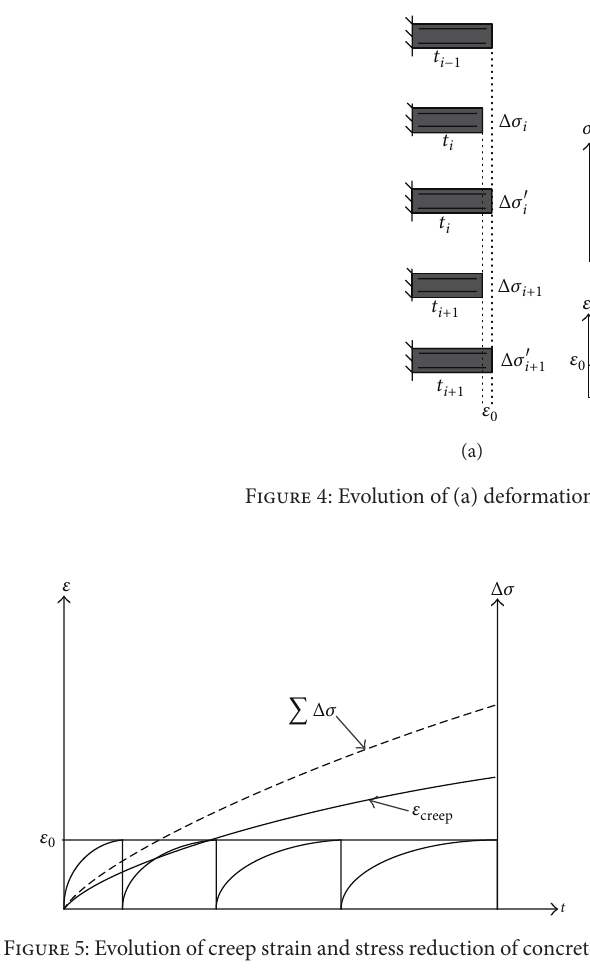
(Figure 6). Concrete was directly cast in the TSTM mould and the top surfaces of all specimens were then covered with a plastic sheet to maintain a constant humidity. Details of temperature stress testing procedure can be found elsewhere [4,